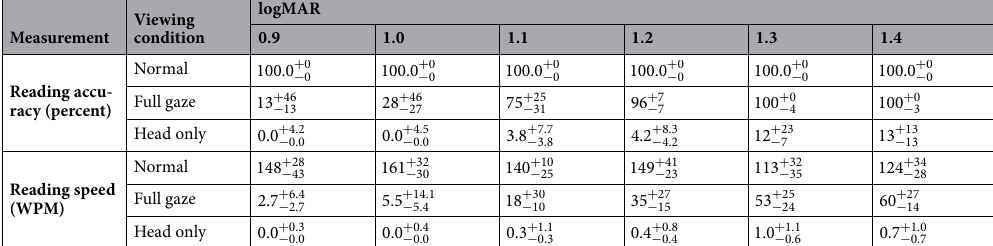
Table 1. Reading accuracy and speed results. Values for reading accuracy in percent correct and reading speed in words per minute (WPM) are given for the three viewing conditions over the population of 23 subjects. Data are presented by font size and given as median values with differences to 16th and 84th percentiles. See Fig. 2 for a graphical presentation of these